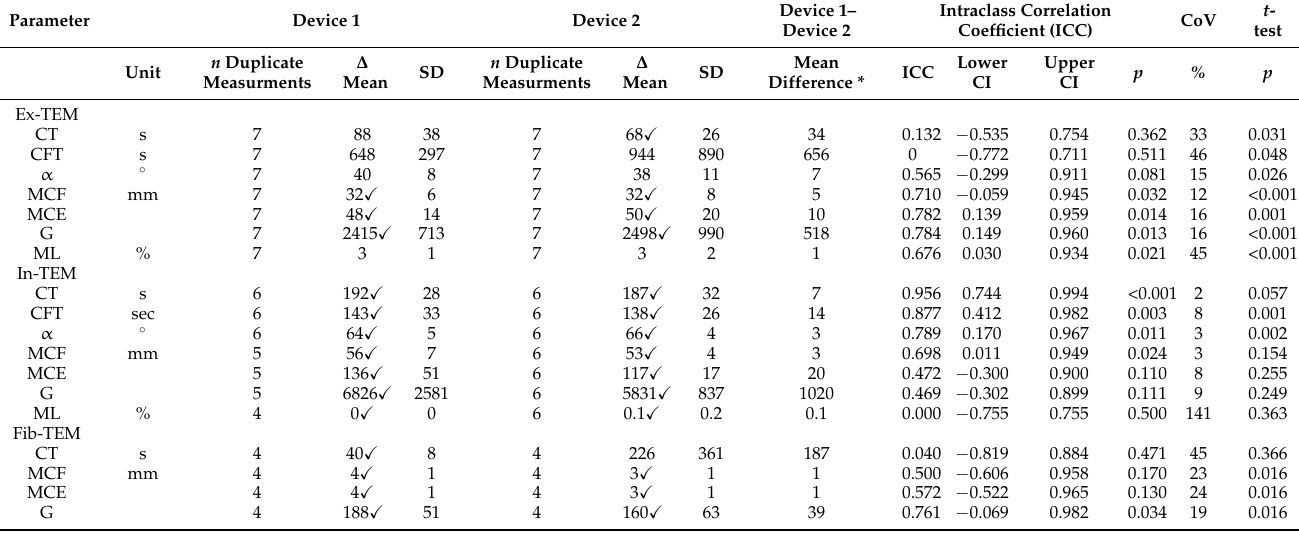
Table 4. Comparison of paired simultaneous ROTEM measurements analyzed by the same operator on two different devices/investigation of in-between device